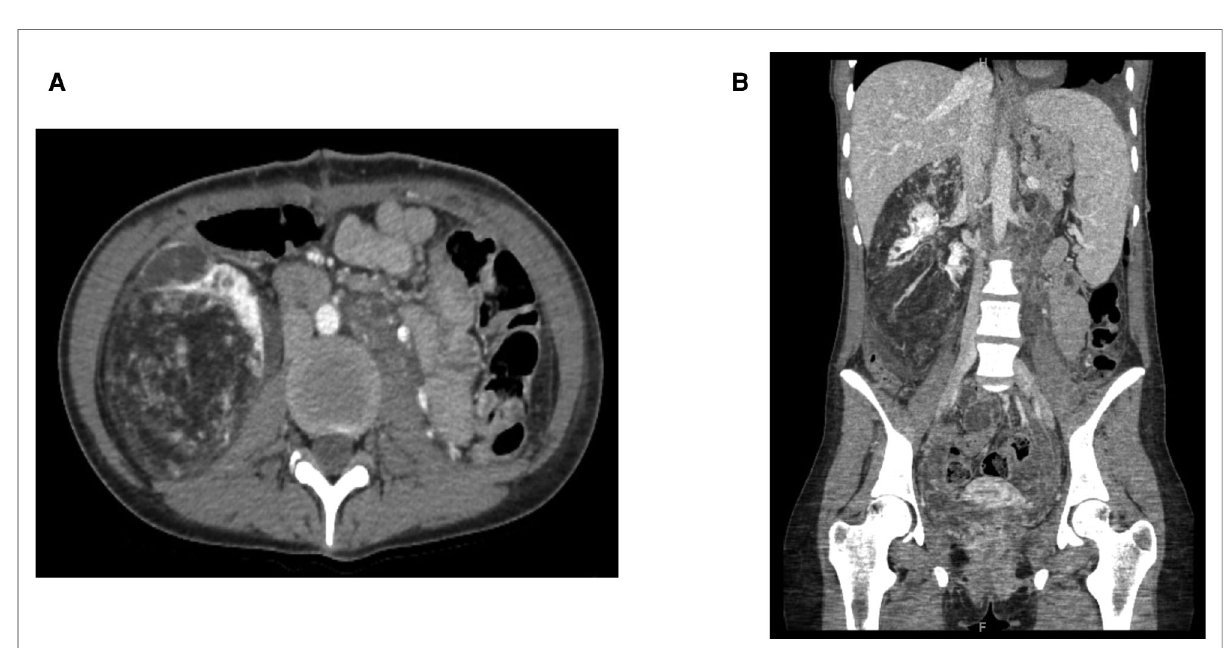
FIGURE 4 Postoperative contrast-enhanced computed tomography of the abdomen: ( A ) axial plane; ( B ) sagittal